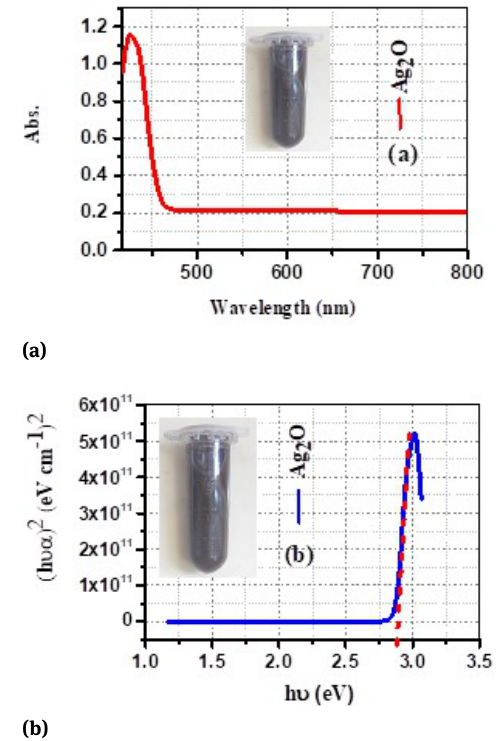
Figure 6: UV-Vis spectrophotometer of green-synthesized Ag 2 O NPs, (a) Absorption spectrum, and (b) energy bandgap (E g ).